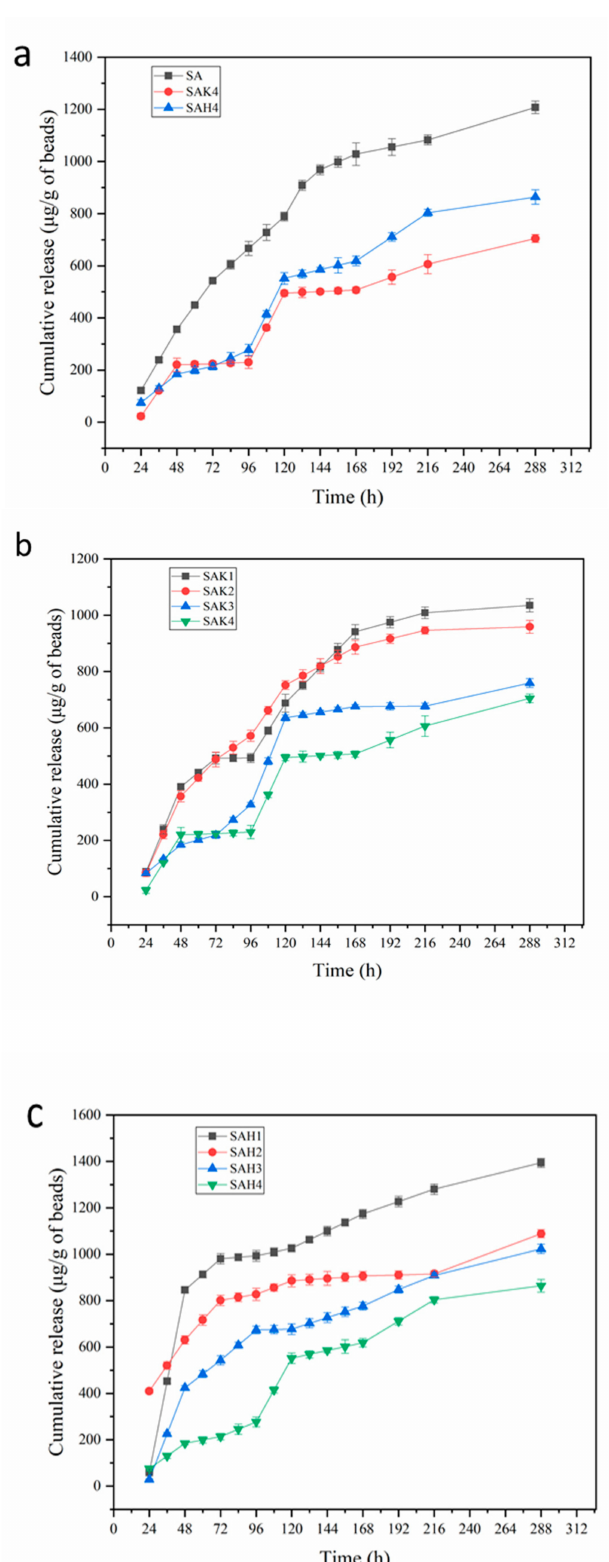
Figure 7. Cumulative release of metalaxyl from starch–alginate based beads: ( a ) With di ff erent formulations ( b ) With di ff erent kaolin contents ( c ) With di ff erent rice husk powder